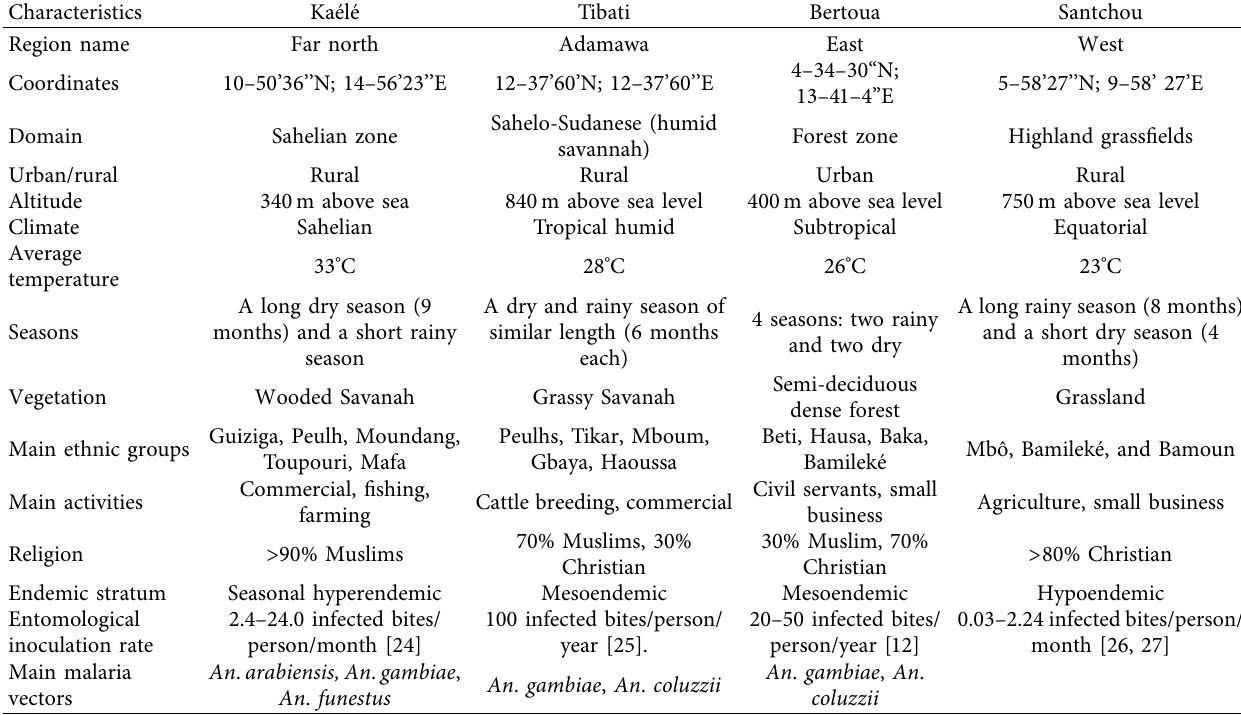
Table 1: Description of the study